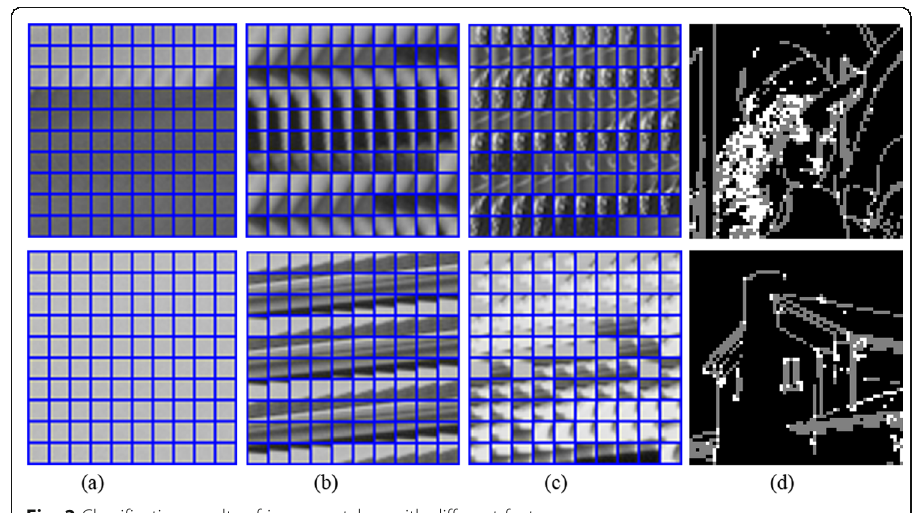
Fig. 2 Classification results of image patches with different